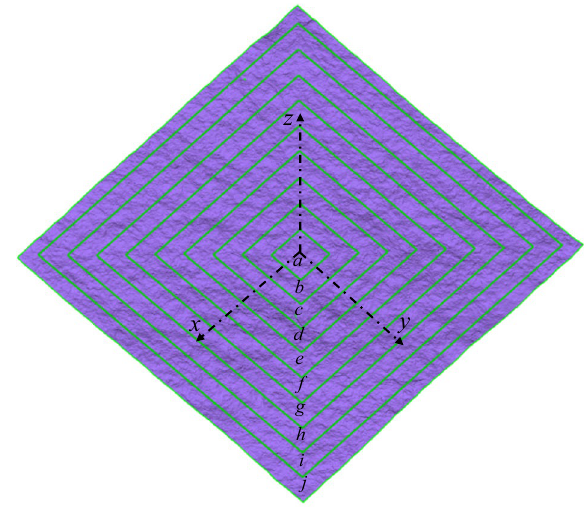
Figure 8. Square joint samples in different sizes from 100 mm × 100 mm to 1000 mm × 1000 mm chosen from the central part of a rock joint surface.